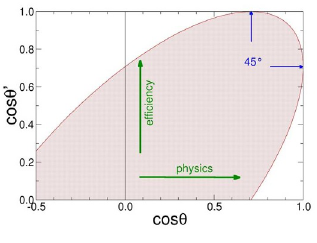
Figure 9: Mapping of the available angles cos θ relative to beam and cos θ (cid:48) to the normal to detectors. The hatched area marks the geo- metrically available